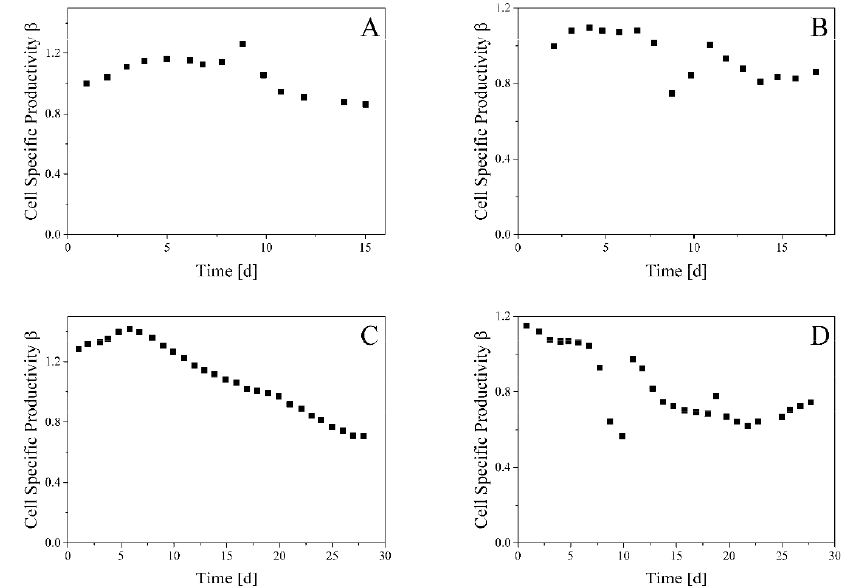
Figure 4. Cell-specific productivity. The cell-specific productivity generally decreases over the course of the four perfusion cell culture experiments ( A ), ( B ), ( C ) and ( D ).